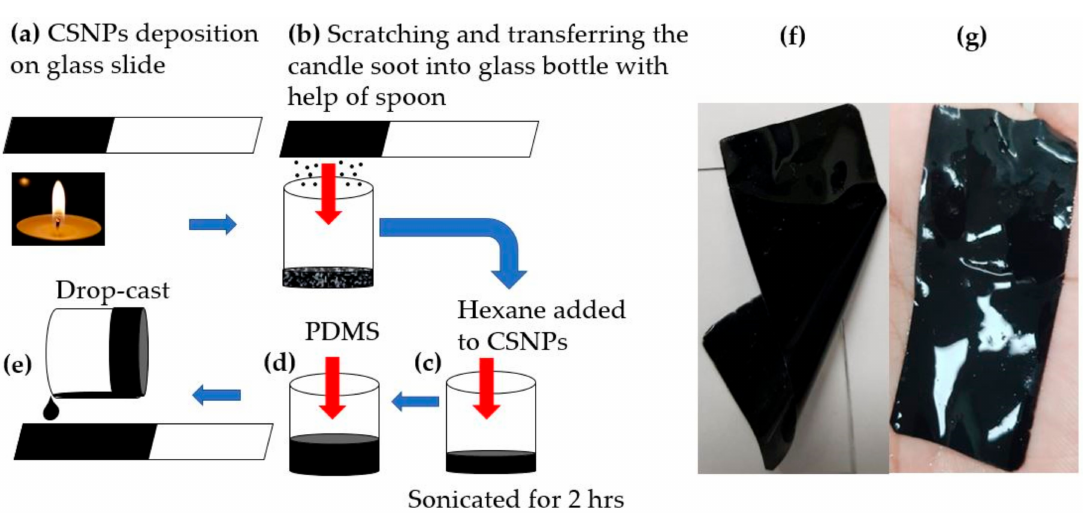
Figure 1. Fabrication process of candle-soot nanoparticles and polydimethylsiloxane (CSNPs–PDMS) nanocomposite. ( a – e ) Steps involved in the fabrication of the nanocomposite transmitter. ( f , g ) Examples of the stretchable nanocomposite films detached from a glass substrate.